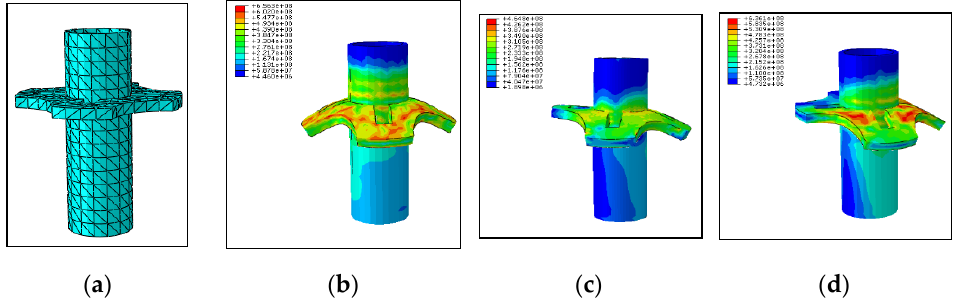
Figure 14. Finite element analysis of wheel shear: ( a ) 𝐹𝐸𝐴; ( b ) central pole; ( c ) side pole; ( d ) corner pole.